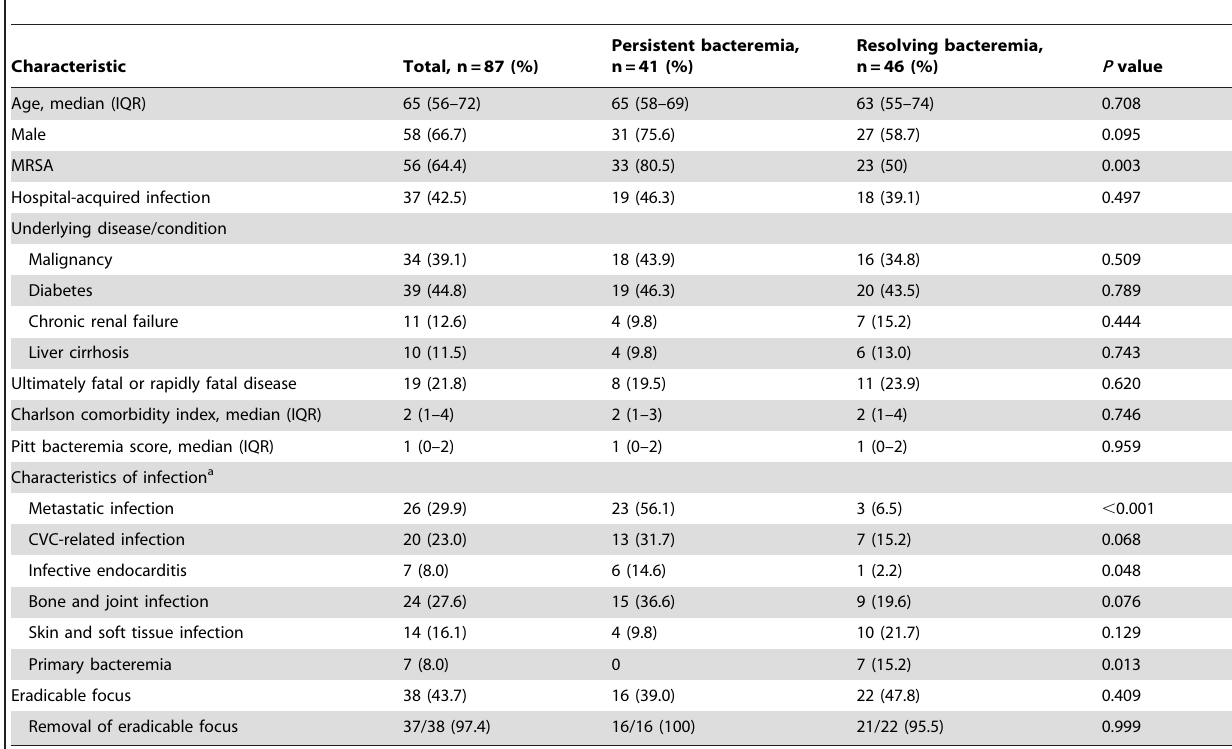
Table 2. Demographic and clinical characteristics of patients with persistent bacteremia and resolving bacteremia caused by Staphylococcus aureus